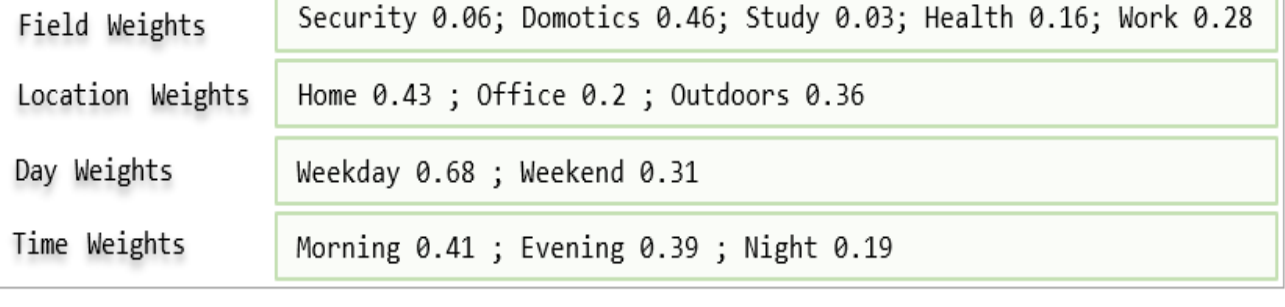
Figure 13. Implicit weights for rules history.